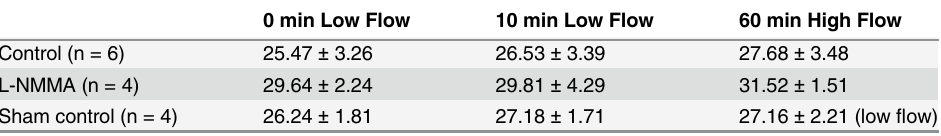
Table 2. Diameters of arterioles under low (~300 μ m/s) and high (~2000 – 2500 μ m/s) fl